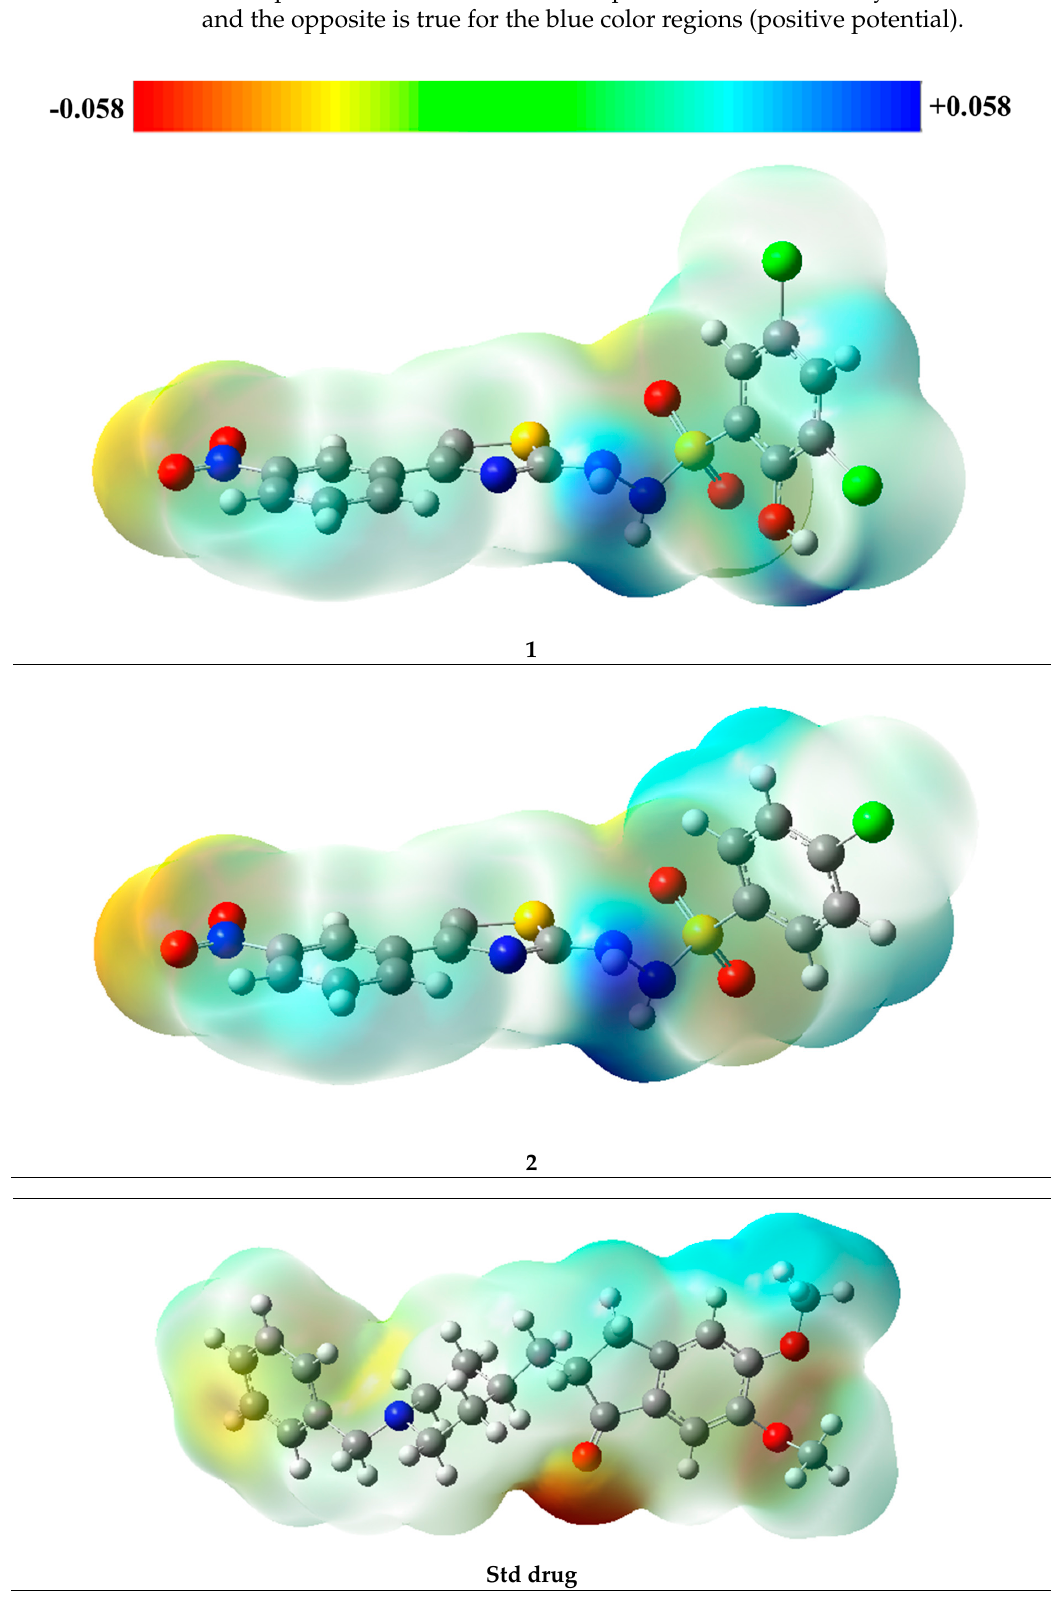
Figure 16. Molecular electrostatic potential (MESP) of representative thiazole-bearing sulfonamide analogs 1 and 2 and Standard drug .